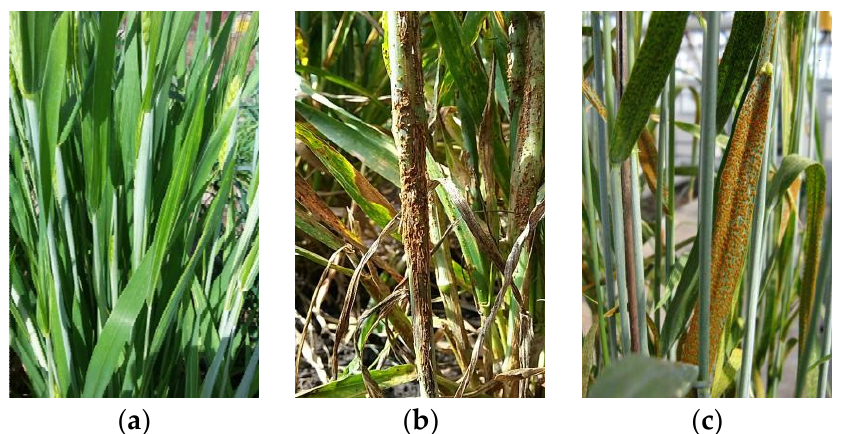
Figure 1. Workflow of this study.